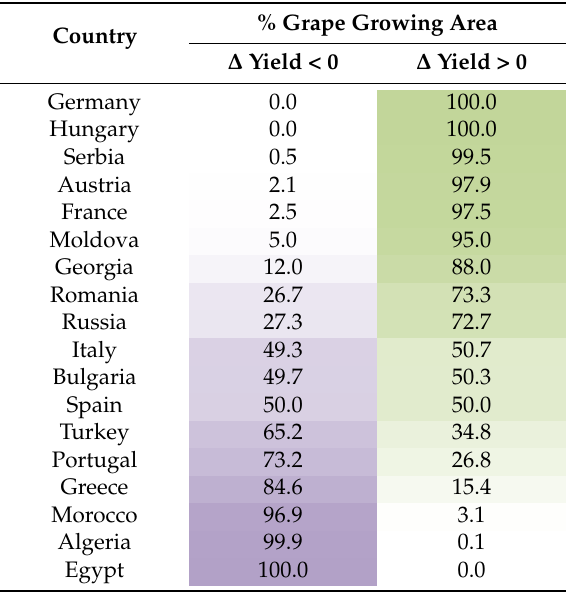
Table 1. Percent fraction (%) of the grape growing area where negative or positive changes in yield ( ∆ yield) are projected under an A1B scenario of 1.8 ◦ C average climate warming in the 18 Euro-Mediterranean countries with the largest vineyard area.